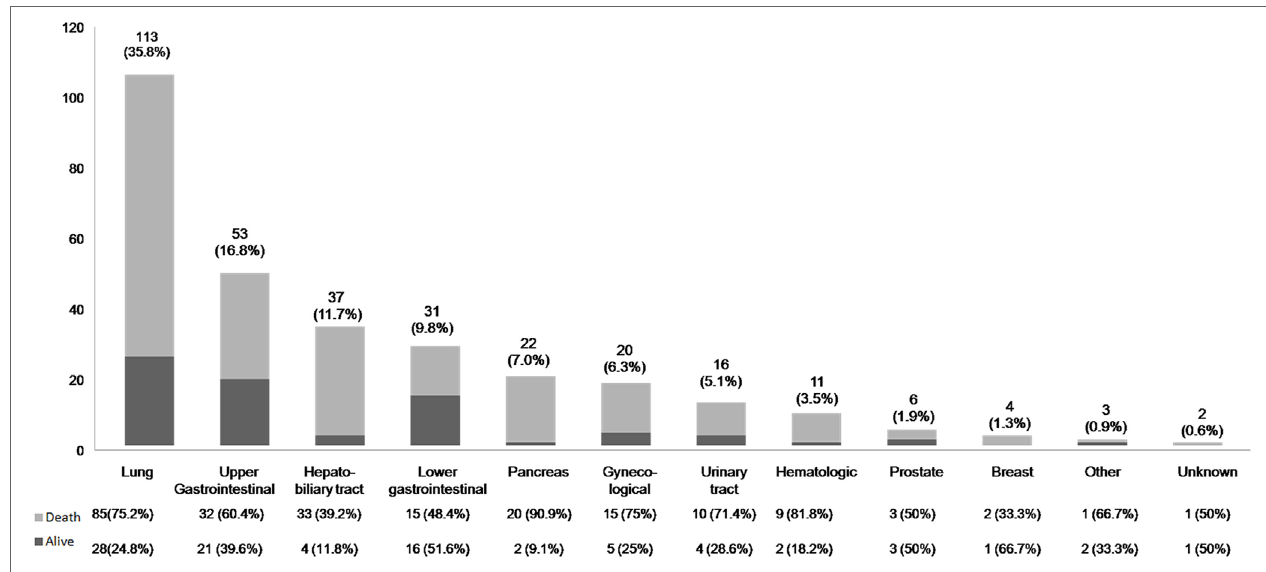
FigUre 2 | Distribution of location of primary cancers and the survival outcome.